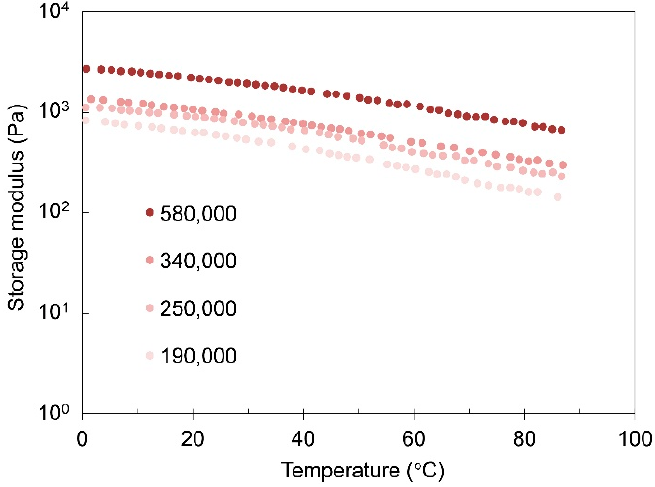
Figure 7. Storage modulus of iPP/tetralin5 gels with different molecular weights of iPP as a function of temperature.